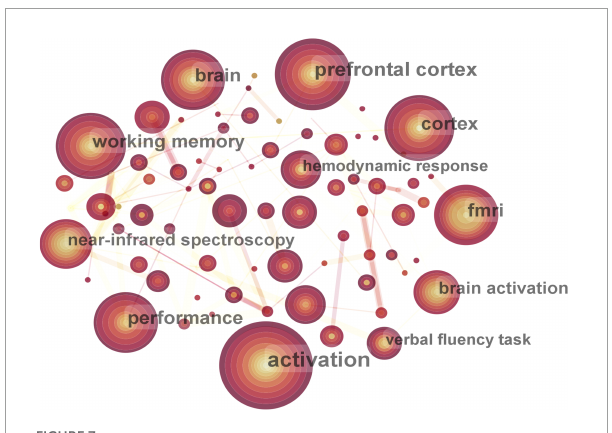
FIGURE7 Map of active keywords in functional near-infrared spectroscopy (fNIRS) research on